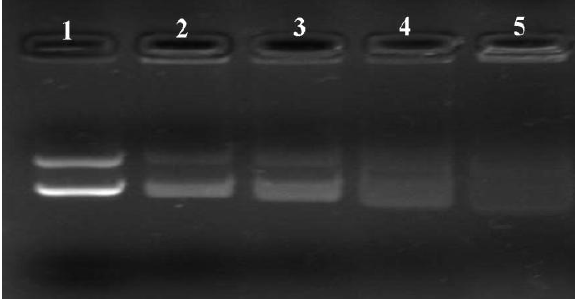
Figure 5. Plasmid DNA extracted from the PLA-PEG-PLL NPs/DNA complexes (N/P 15:1) by the addition of different concentration of heparin solution. Lane 1: Naked DNA; Lane2-5: PLA-PEG-PLL NPs/DNA complexes extracted with 1% heparin, 2% heparin, 5% heparin and 10% heparin, respectively.